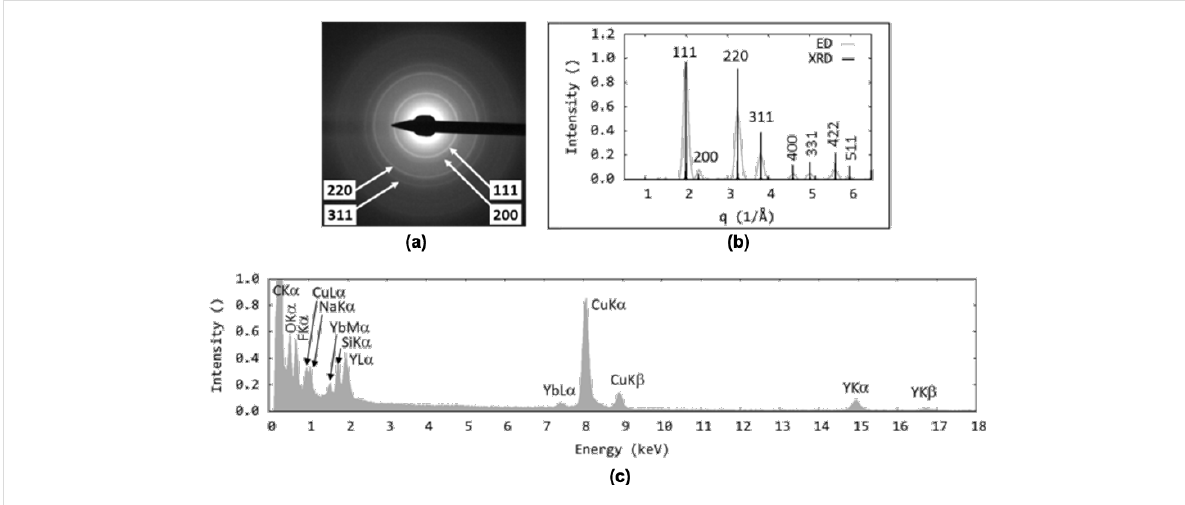
Figure 4: TEM analysis: (a) ED pattern, (b) comparison of experimental ED pattern and calculated XRD pattern, and (c) EDX spectrum of no. 1 OM–NaYF 4 :Yb 3+ /Er 3+ nanoparticles. Peaks were indexed according to [20].